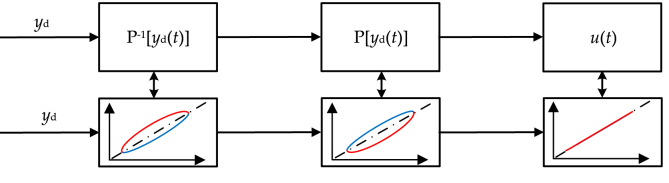
The schematic of feedforward control.